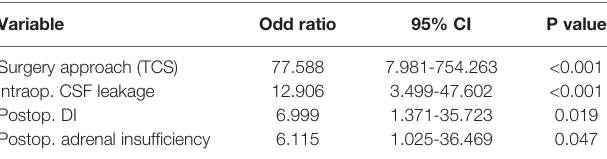
TABLE 5 | Multivariate analysis of factors associated with postoperative central nervous system infection.